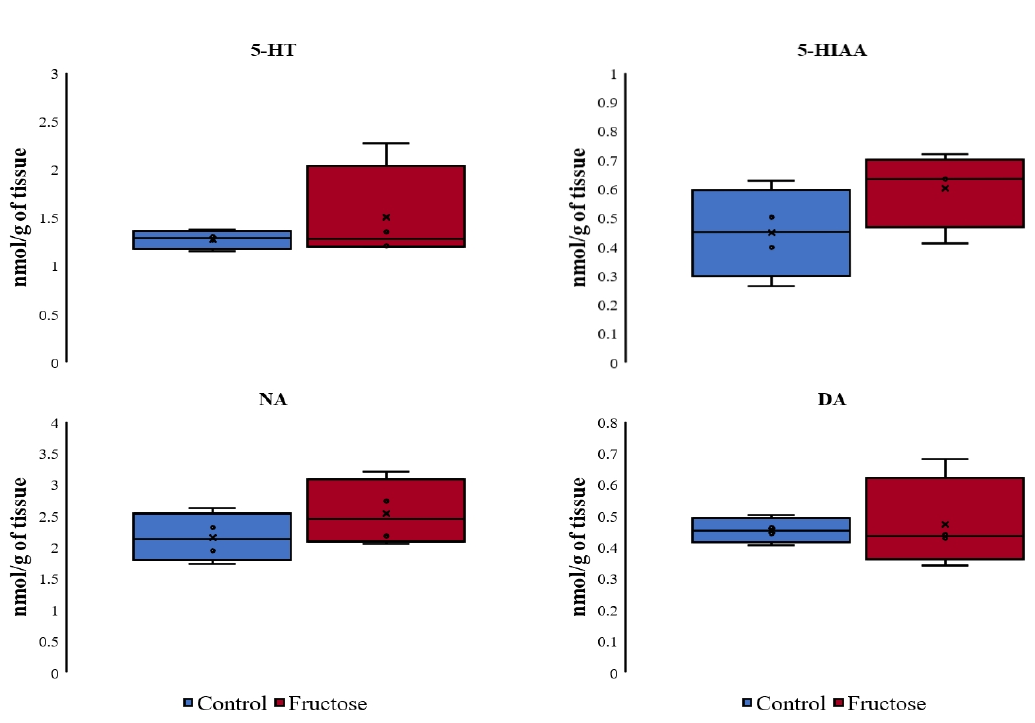
Figure 5. Concentration of monoamines in the hypothalamus and brainstem after the chronic ingestion of fructose. Other abbreviations used: serotonin (5-HT), 5-hydroxyindolacetic acid (5-HIAA) and noradrenaline (NA). Box plots represent the median, interquartile range, and minimum and maximum values. N = 4 – 6 per group. The differences between the groups were analyzed with a Mann–Whitney rank sum test (* p < 0.05 vs. control group).